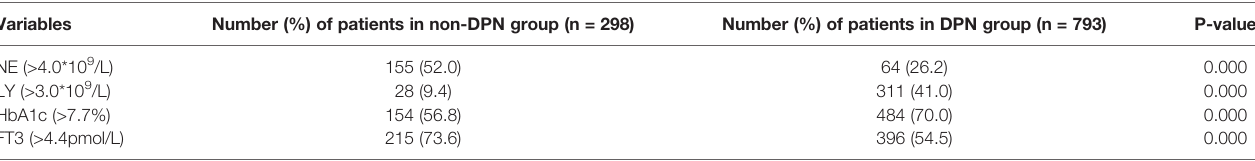
TABLE 3 | Comparison of categorical variables between non-DPN group and DPN group. Variables Number (%) of patients in non-DPN group (n = 298) Number (%) of patients in DPN group (n = 793)